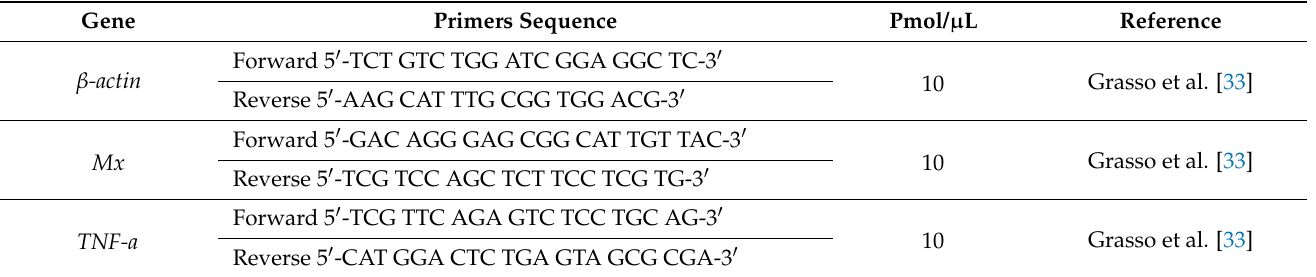
Table 3. Primers used to assess the immune system in